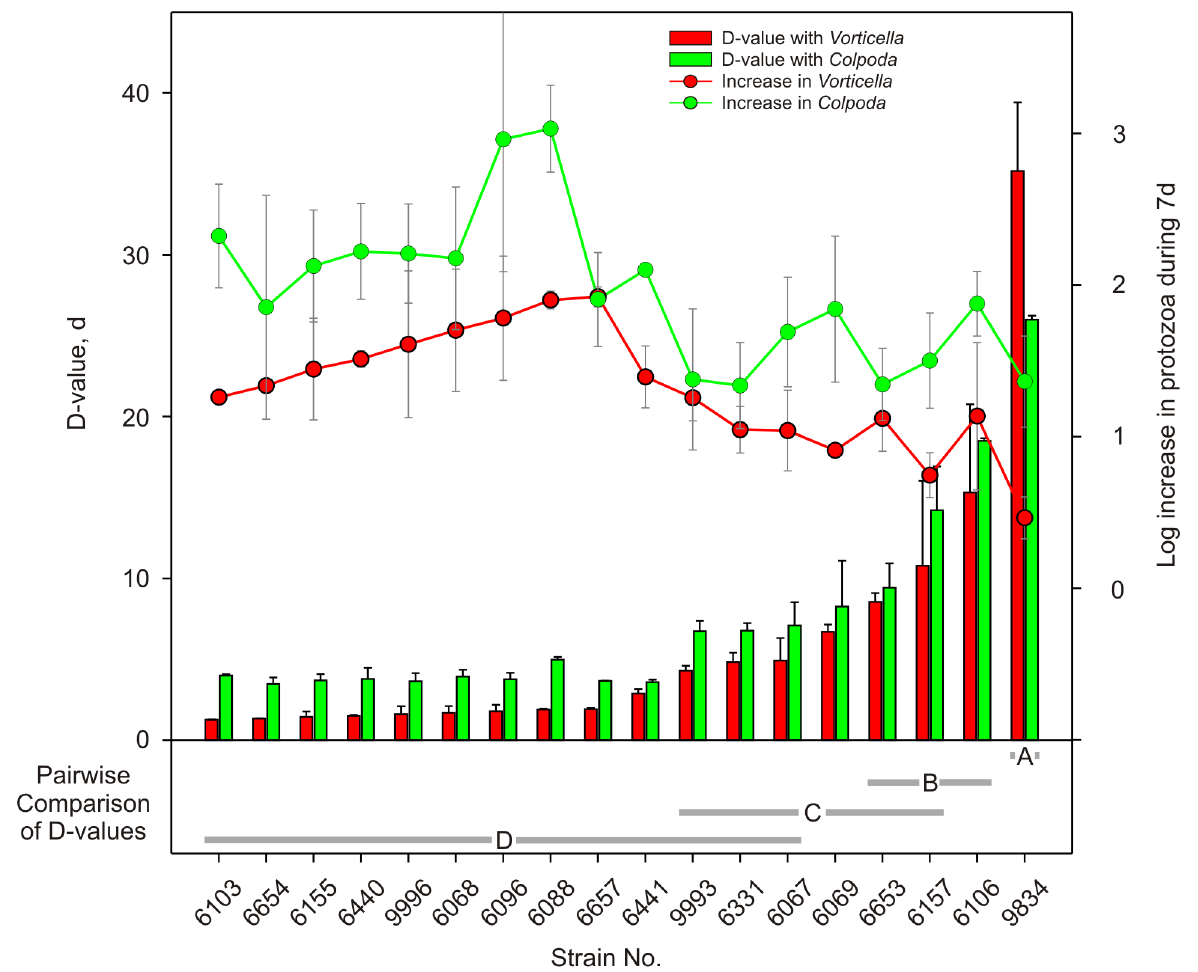
Figure 1. Inter-strain differences in preferential predation of EcO157 by protozoa from dairy wastewater. Survival of EcO157 populations measured as D-values (bar graph) and resultant increases in log numbers (line graph) of V. microstoma and C. aspera are shown.